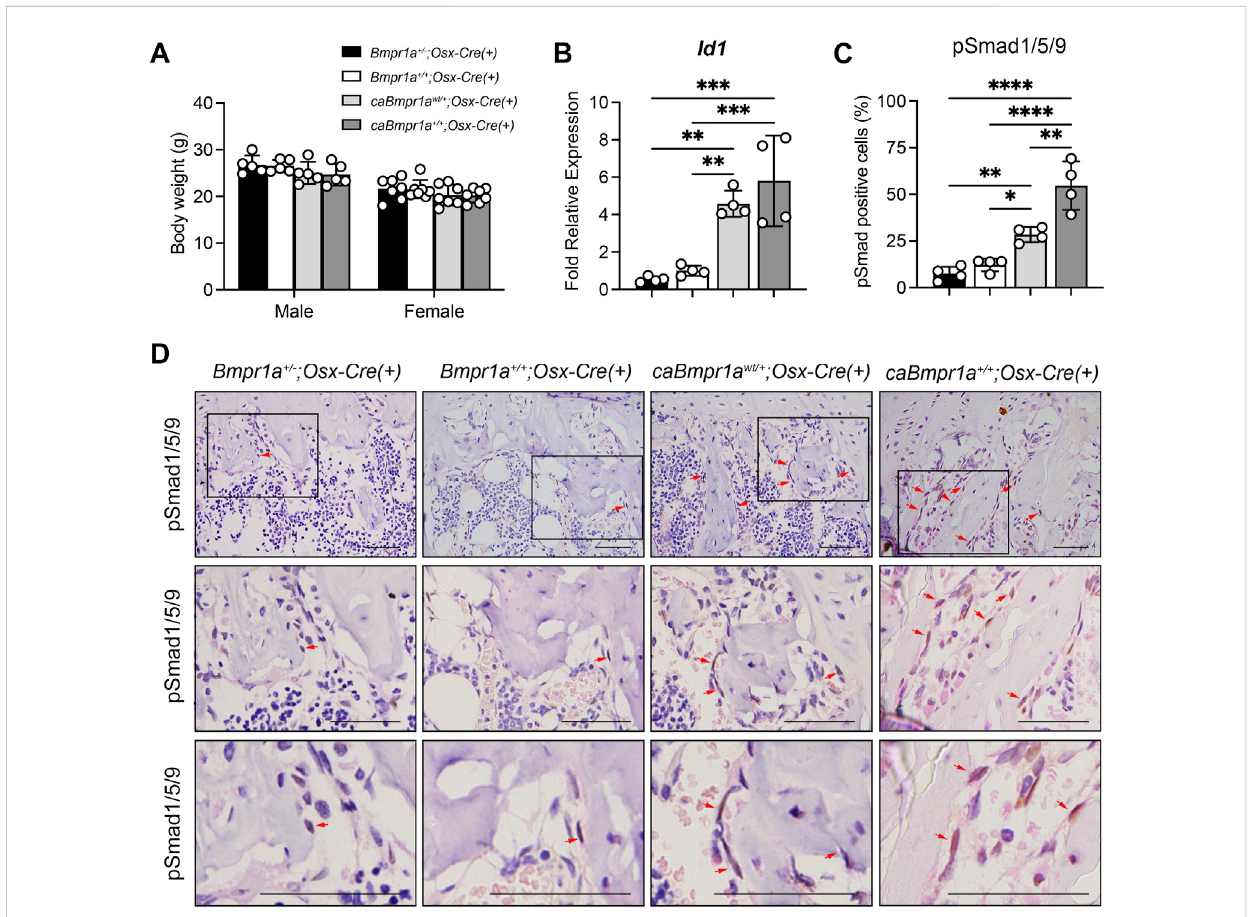
FIGURE 1 Genotype dependent upregulation of BMP-Smad signaling activity. (A) Body weight of the mice at 12 weeks of age (male: n = 5 for each group, female: n = 7 for each group). (B) Expression levels of Id1 , atargetgene of BMP signaling, in tibiae were measured at12 weeks of age (n = 4 male for each group). (C, D) Immunohistochemical detection of phosphorylated form of Smad1/5/9 in tibiae at 12 weeks of age. pSmad1/5/9-positive cells (brown staining) were marked by red arrows. Higher magni fi cation photos are also shown. Scale bar = 50 µm (D) . The ratio of pSmad1/5/9-positive cells (brown + blue) to total cells (blue) on the bone surface ofthe trabecular bone was analyzed (n = 4 male for each group) (C) . **** p < 0.0001, *** p < 0.001, ** p < 0.01, and * p <